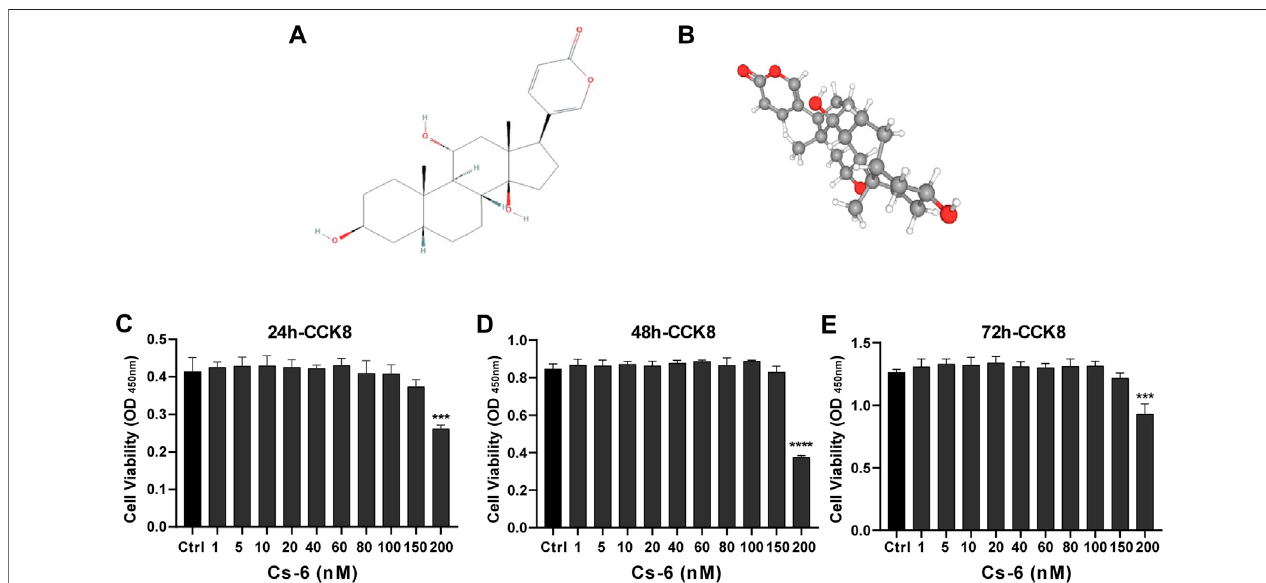
FIGURE 1 | Chemical structure and cytotoxicity of gamabufotalin (CS-6) on osteoclast precursor cells (bone marrow – derived monocyte – macrophage (BMM) lineage). (A, B) Chemical structure of CS-6. (C – E) Cell viability of BMMs as evaluated by CCK-8 assay following treatment with or without indicated concentrations of CS-6 at the time point of (C) 24, (D) 48, and (E) 96 h, respectively. Values were presented as the mean ± standard deviation ( n (cid:2) 5); * p < 0.05, ** p < 0.01, *** p < 0.001, **** p < 0.0001.